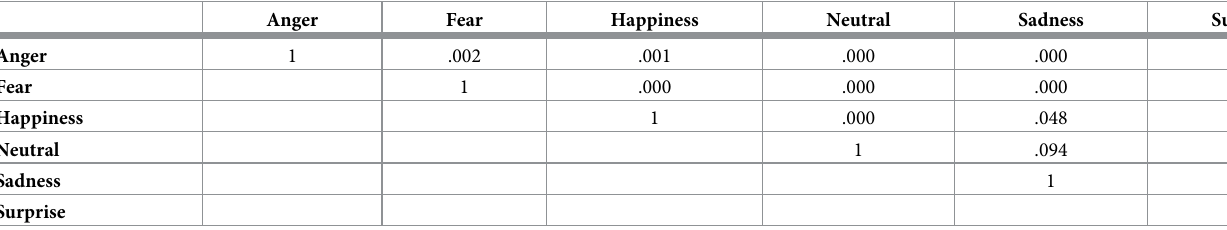
Table 22. Pairwise Dunn’s test for Phase 2 emotions.